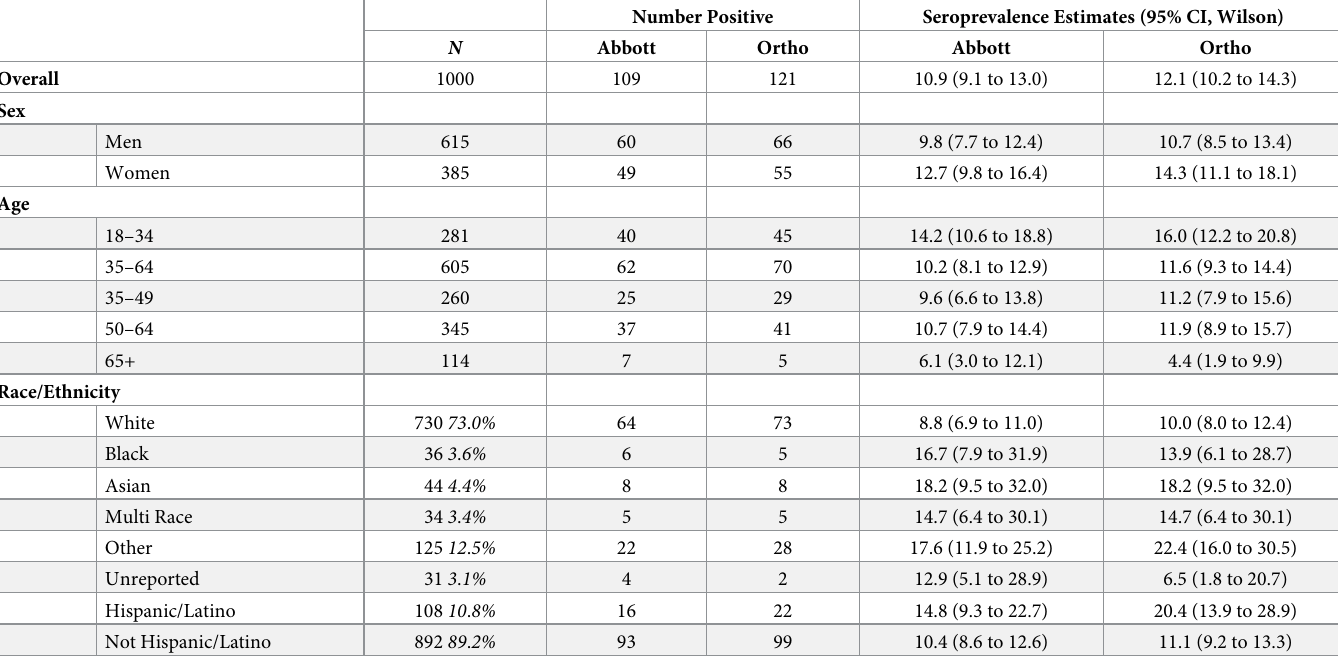
Table 1. NYC metro seroprevalence estimation within demographic categories.